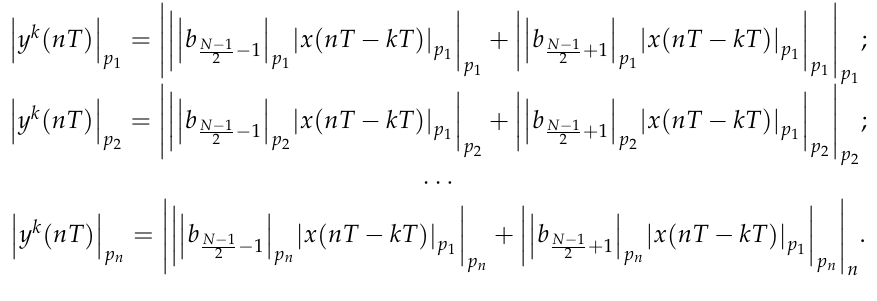
Table 2. Values of the intermediate samples of the modular DF for the coefficients b 0 and b N − 1 .